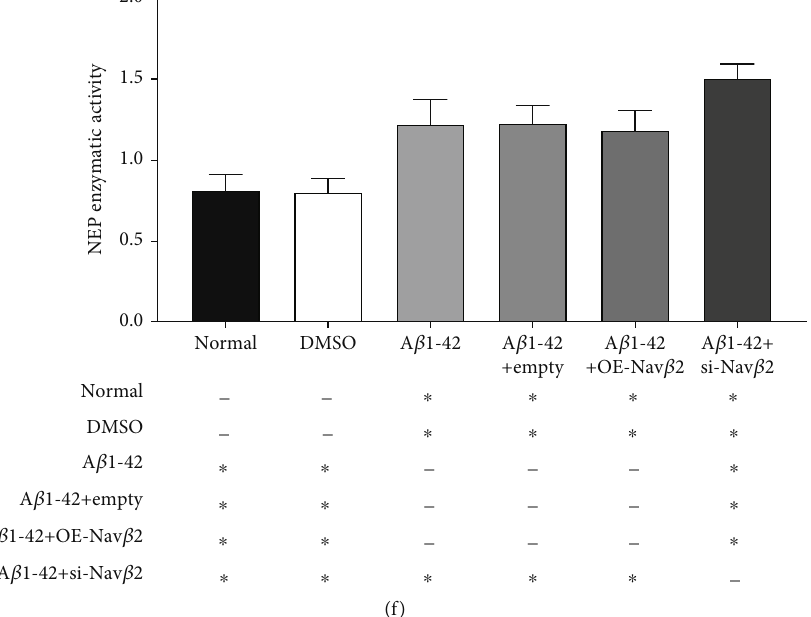
Figure 6: E ff ects of A β 1-42 and Nav β 2 on APP, BDNF, and NEP in A β 1-42-treated mice. (a) Representative blots of Nav β 2, APP, BDNF, NEP, and GAPDH in mice with various treatments indicated by Western blot assay. (b – e) Quantitative plots of Nav β 2, APP, BDNF, and NEP in hippocampus of mice from di ff erent groups. (f) Quantitative image of NEP enzymatic activity between each experimental group. Intragroup sample size n = 7 . ∗ Versus two di ff erent treatment groups, P < 0 : 05 . # Compare the remaining treatment groups with the marker group, P < 0 : 05 . - Versus two di ff erent treatment groups, P > 0 : 05 . Empty: empty viral vector; OE: overexpression; si: small